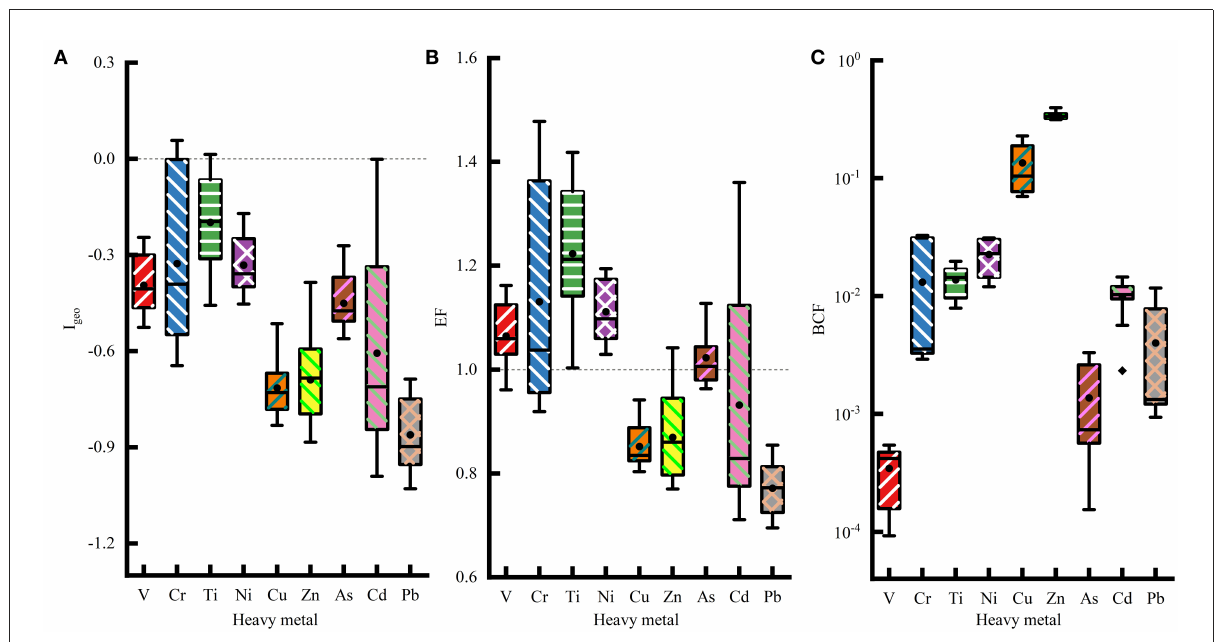
FIGURE3 The pollution status assessment of soil and maize heavy metal. Geo-accumulation index (Igeo) (A) and enrichment factor (EF) (B) of soil, and bioaccumulation factor (BCF) (C) of maize for heavy metal pollution in the study area.